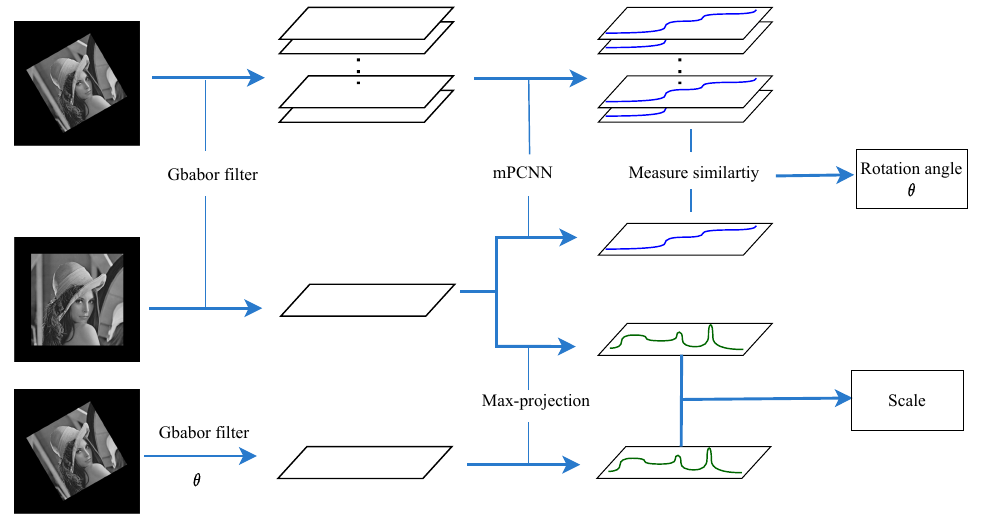
Figure 1. Schematic diagram of the proposed